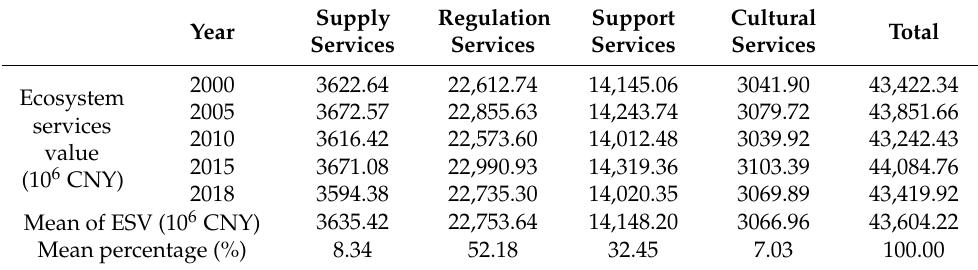
Table 4. Proportion of various ecosystem services in